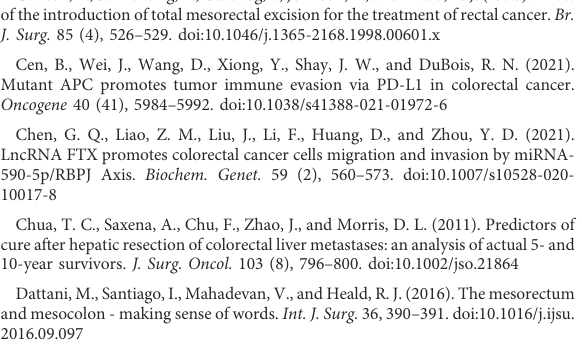
SUPPLEMENTARY FIGURE S1 (A – D) Heatmap expression of LAG3, PDCD1, PDCD1LG2, and TIGIT associated with 28 prognostic cuproptosis-related lncRNAs, respectively. SUPPLEMENTARY FIGURE S2 (A – C) Survival graphs of high and low risk groups in StageI+II, N0, and T1+T2